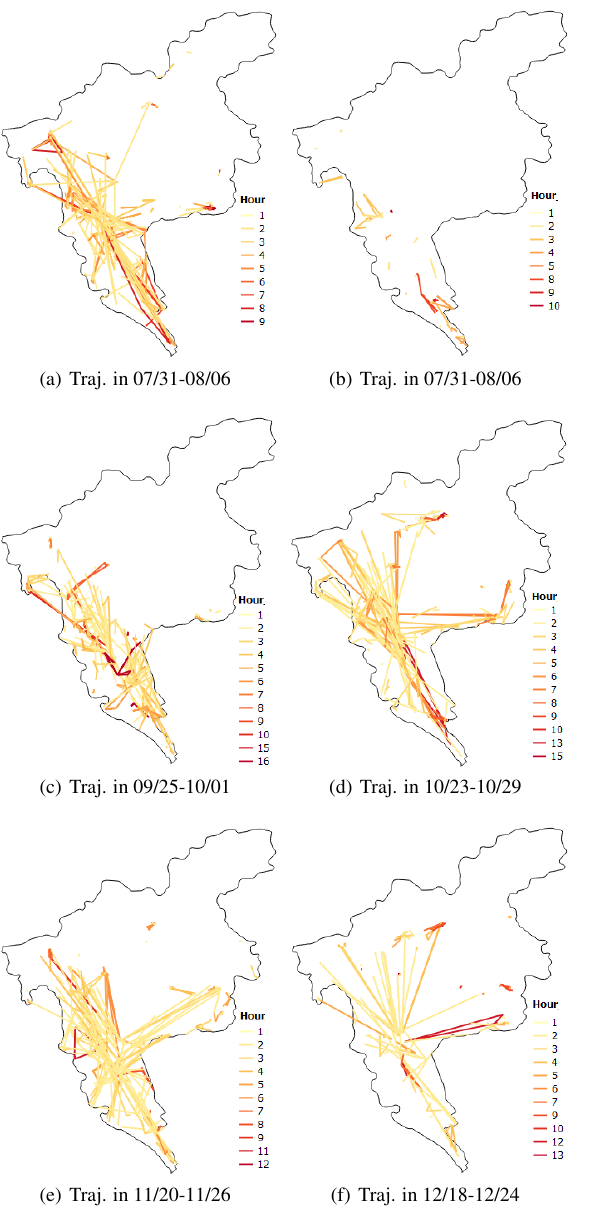
Figure 7. Zone of UHIs associated with their trajectories. Lager area of the zone has larger circle